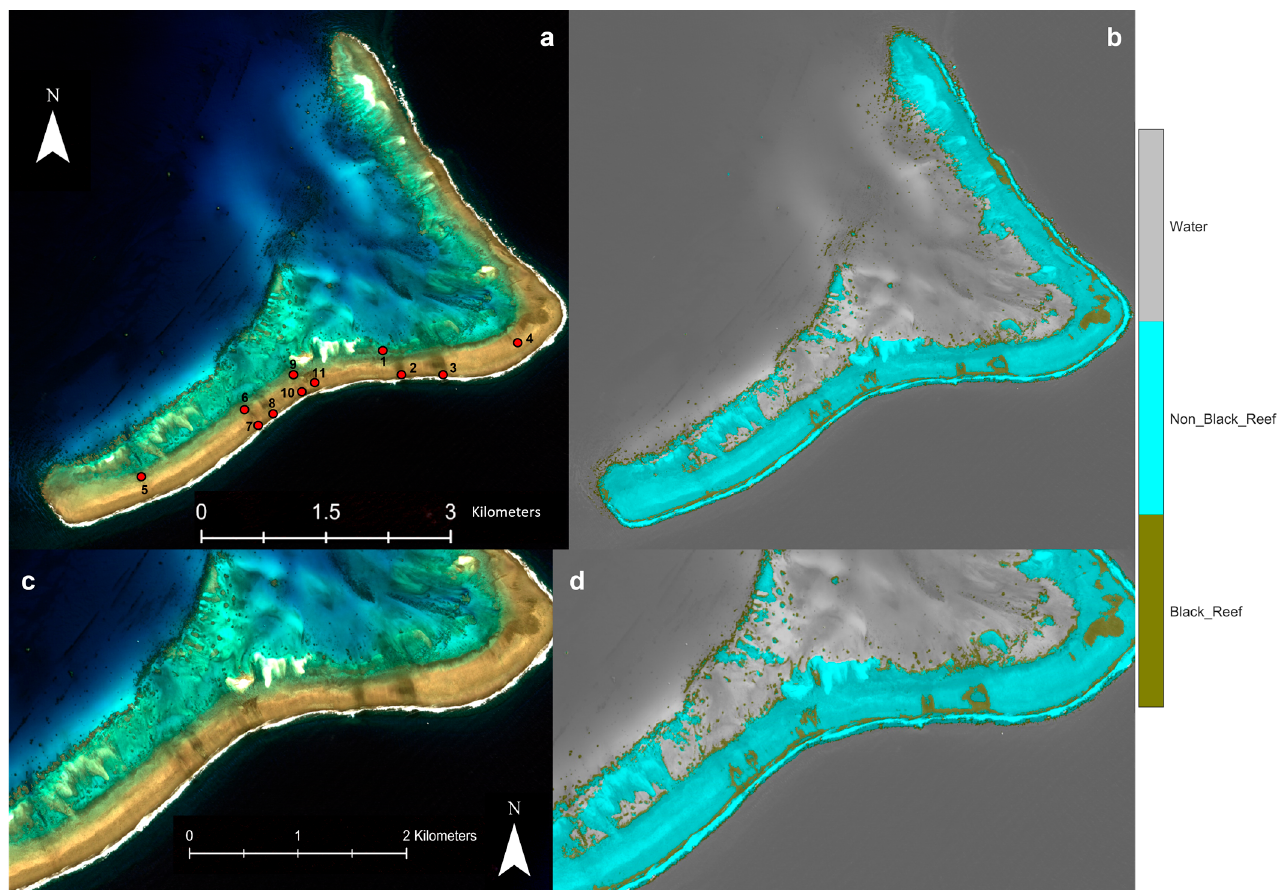
Figure 7. ( a ) Vision-1 satellite image of Kenn reef with the location of the 11 known shipwrecks (red dots), ( b ) the resulting segmented image after the application of the trained algorithm, ( c ) zoomed part of the Google Earth image and ( d ) the corresponding zoomed part of the segmented image.